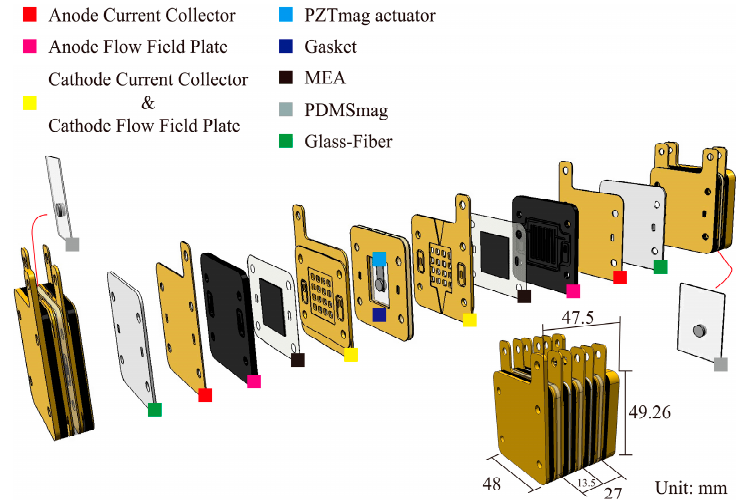
Figure 4. Schematic diagram of the bi-cell PZTmag–PEMFC stack.